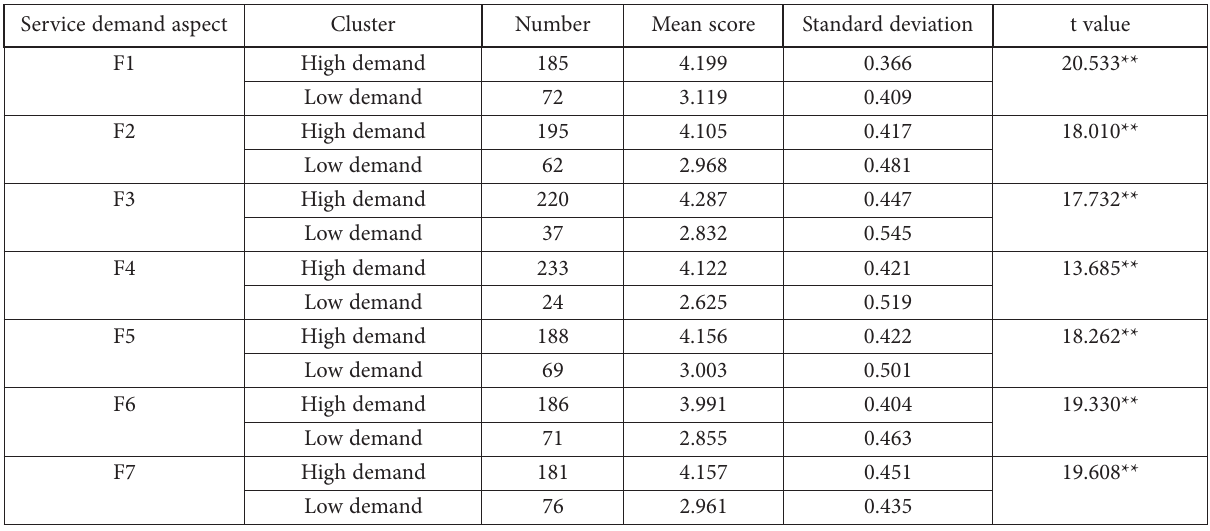
Table 5. Cluster of high- and low-demand groups